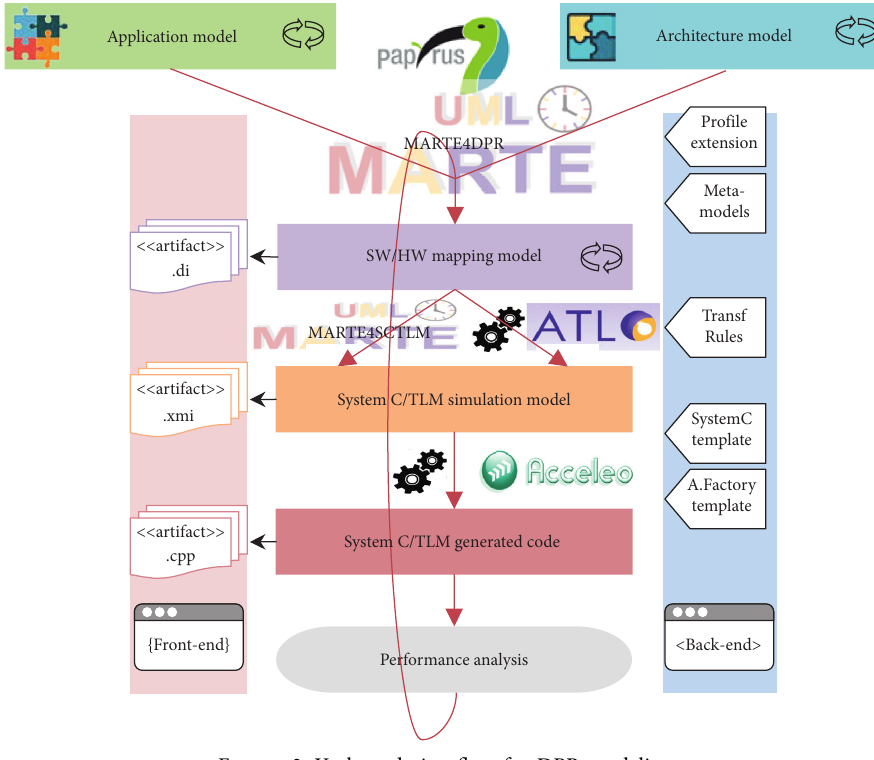
Figure 3: Y-chart design flow for DPR modeling.